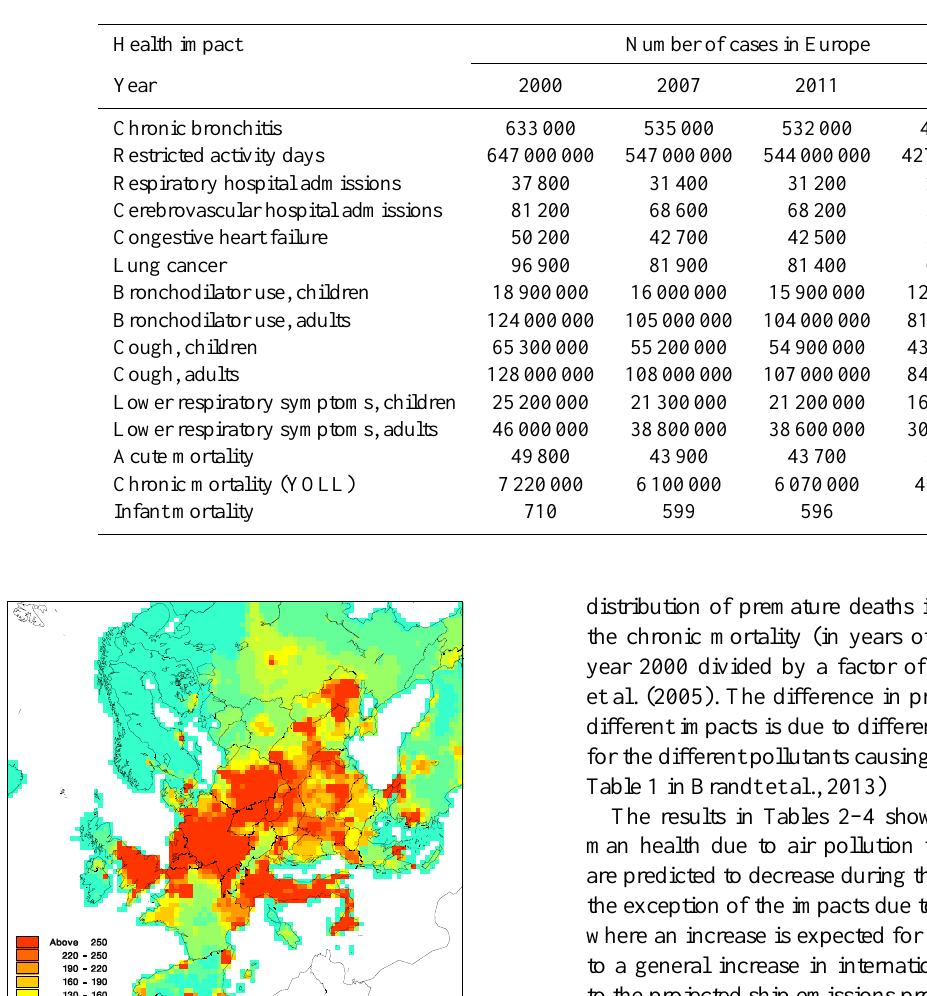
Table 4. Total number of cases in Europe of the different impacts related to all the emissions in the Northern Hemisphere – i.e. the total air pollution levels (scenario: All/all) for the four different years.